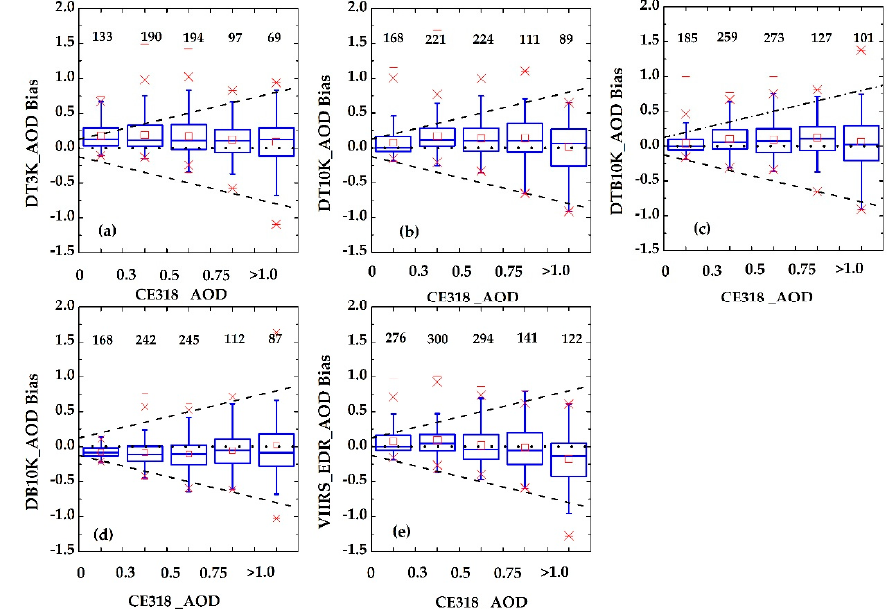
Figure 7. Box plots of high-quality Aqua-MODIS C6 and VIIRS_EDRAOD retrieval biases (AOD satellite - AOD CE318 ) against CE318 AOD observations over YRB for the period of 2 May 2012–31 December 2016. The dot line is the y = 0 line and the dashed lines are the EE envelopes. The number above each box refers to the corresponding matchups in the different intervals of CE318 AOD (1–0.3, 0.1–0.5, 0.1–0.75 and >1.0). The DT3K, DT10K, DTB10K, DB10K and VIIRS_EDRAOD retrieval biases are presented in ( a – e ), respectively.